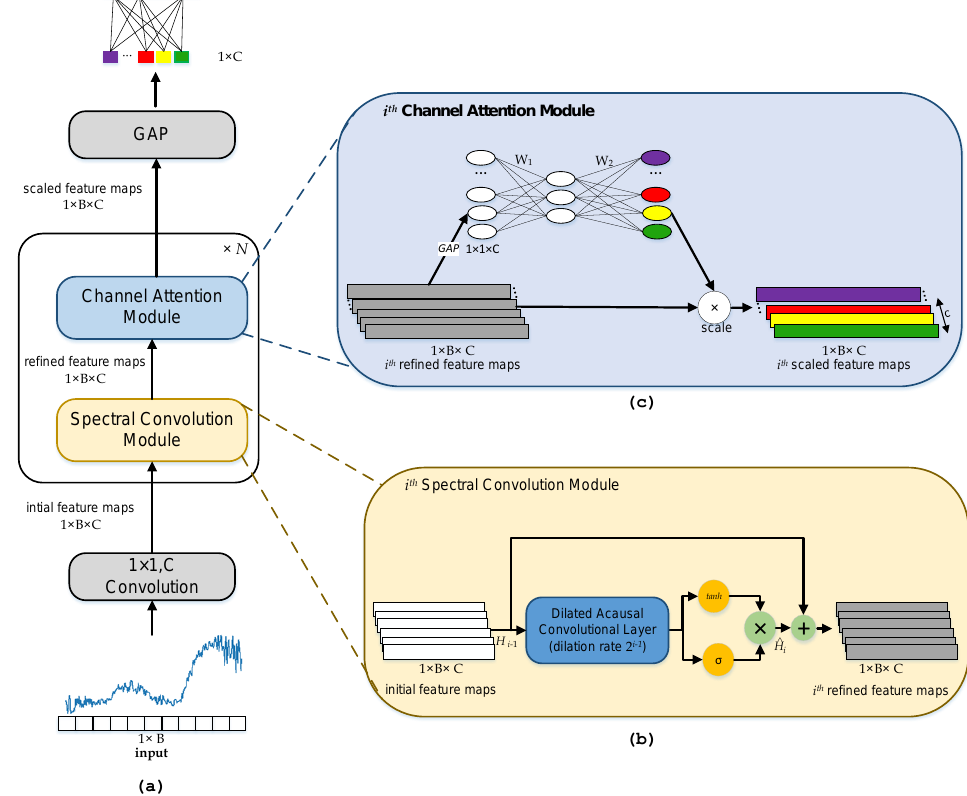
Figure 2. ( a ) Overview of the proposed network, ( b ) the detail of a spectral convolution module, which consists of a dilated convolutional layer that residually connected and has two activation functions, “ tanh ” and “ σ ” (sigmoid), and ( c ) the architecture of a channel attention module, which utilizes global average pooling along the spectral axis and fully connected layers to compute inter- relationship between channel-wise feature